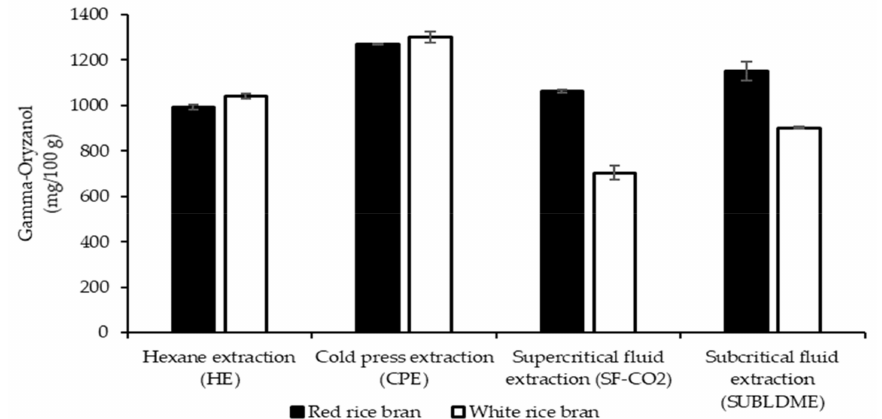
Figure 2. The γ -oryzanol contents of crude rice bran oil extracted using various extraction